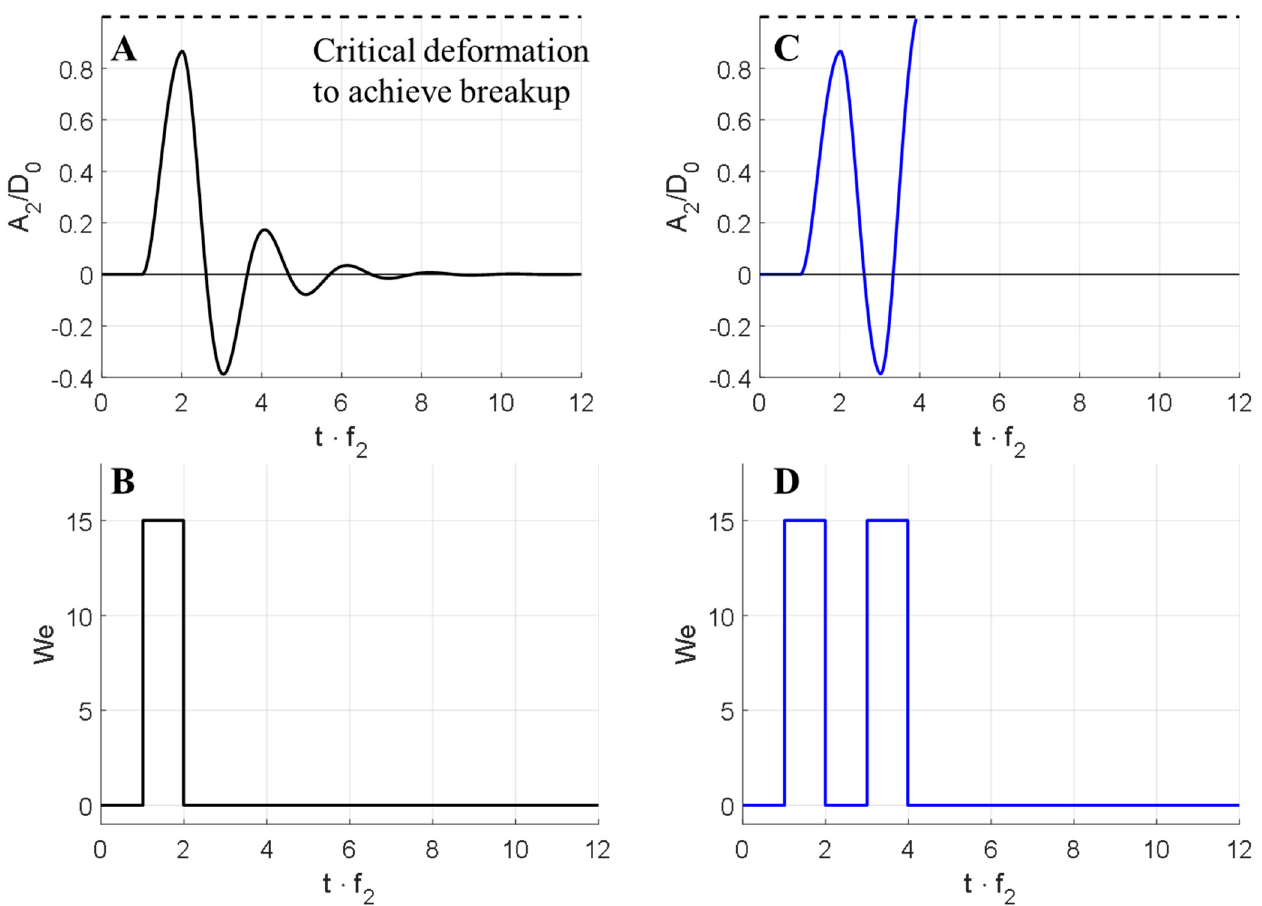
Figure 12. Illustration of the Rayleigh–Lamb model (Equation (35)), showing the effect of a sequence of eddies; ( A ) and ( B ) show how the drop amplitude behaves when encountering a single high ‐ We pulse (We = 15) with a duration (f 2 Δ t = 1); ( C ) and ( D ) show how the drop amplitude behaves when encountering two successive pulses separated by a time Δ t . (Settings as in Figure 11.)